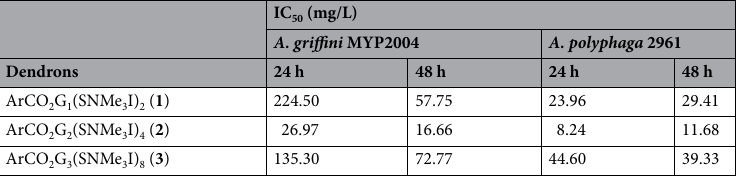
Table 2. IC 50 (mg/L) values in A. griffini MYP2004 and A. polyphaga 2961 after 24 and 48 h of dendron treatment. ArCO